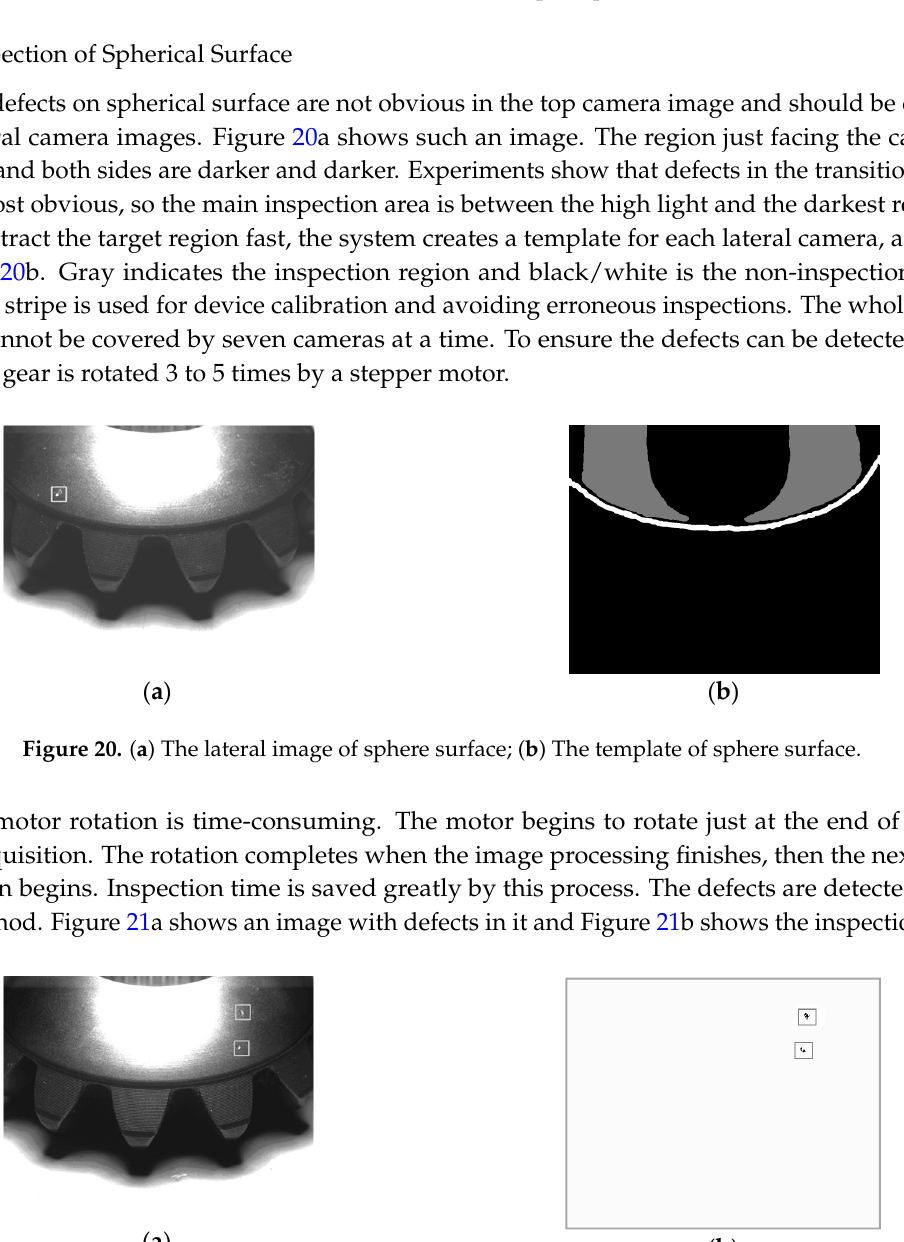
Figure 19. Defect detection of top ring on bottom surface: ( a ) Top ring extraction; ( b ) Top ring fitting (red circles); ( c ) Result of defect detection; ( d ) Defects after open-operation.